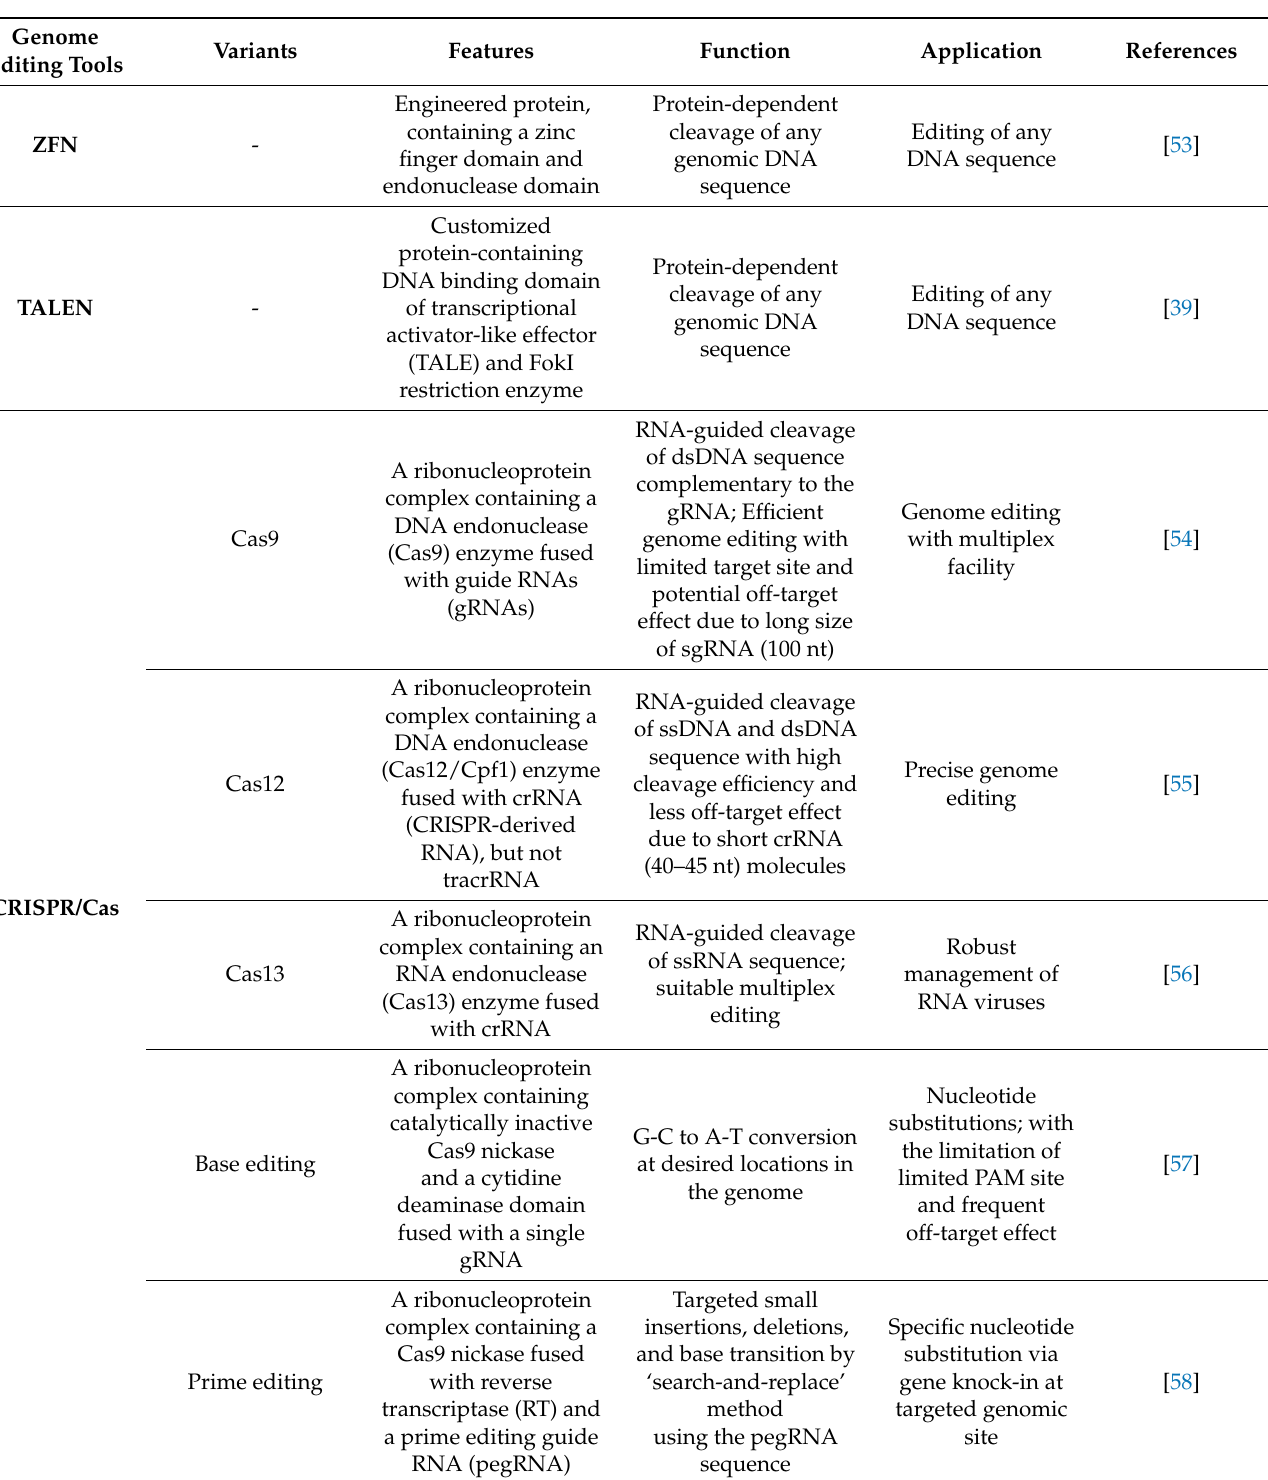
Table 1. Advancements in genome editing tools and their variants are available for rice